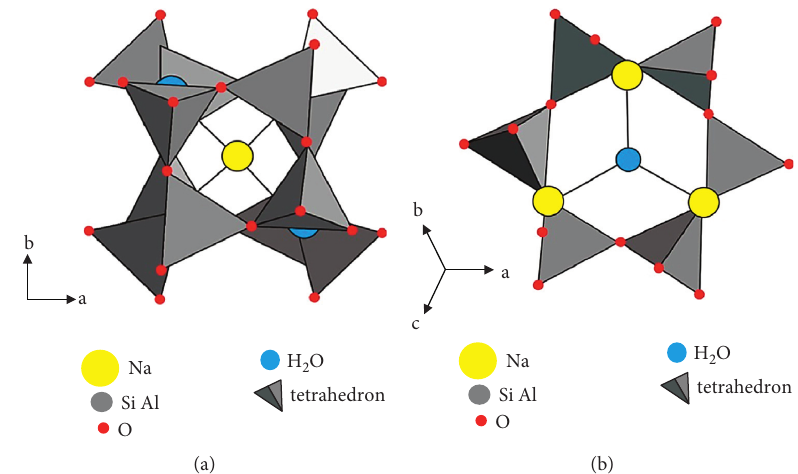
Figure 1: Crystal structure of analcime (Armbruster and Gunter, 2001; Xiao, 2014) [30, 36]. (a) Four-membered ring structure. (b) Six- membered ring structure.